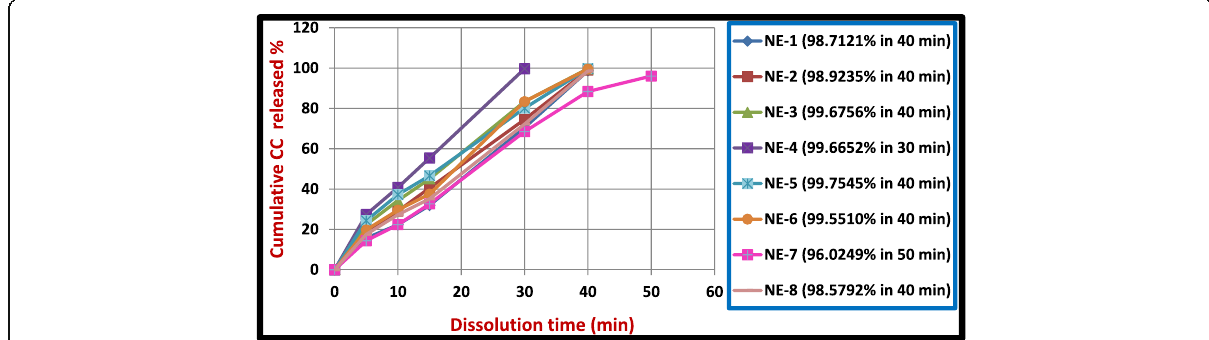
Fig. 8 A comparative dissolution profile of candesartan cilexetil nanoemulsions (NE- 1, NE-2, NE-3, NE-4, NE-5, NE-6, NE-7 and NE-8 in 900 ml of 0.1 N HCl dissolution medium (pH 1.2) with 0.5% tween 20 at 37 °C